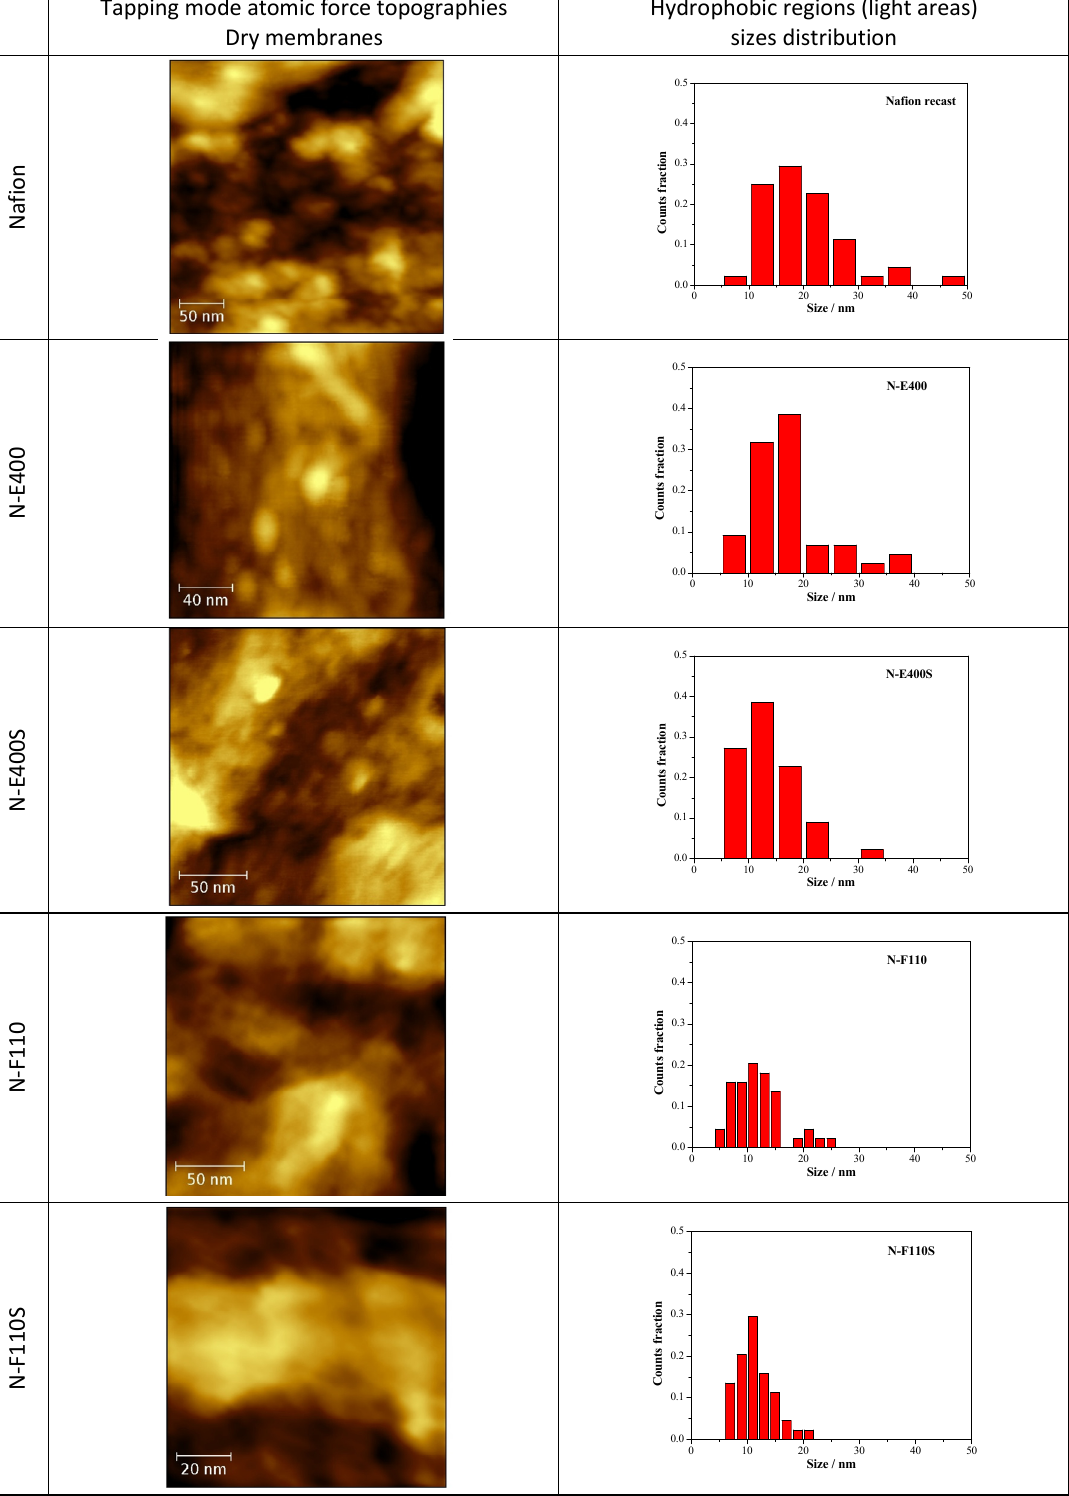
Figure 7. Atomic force microscopy (AFM) topographies measured in tapping mode of the five dried membranes and size distribution of the hydrophobic regions as derived from the image analysis. Tapping mode atomic force topographies Hydrophobic regions (light areas) Dry membranes sizes